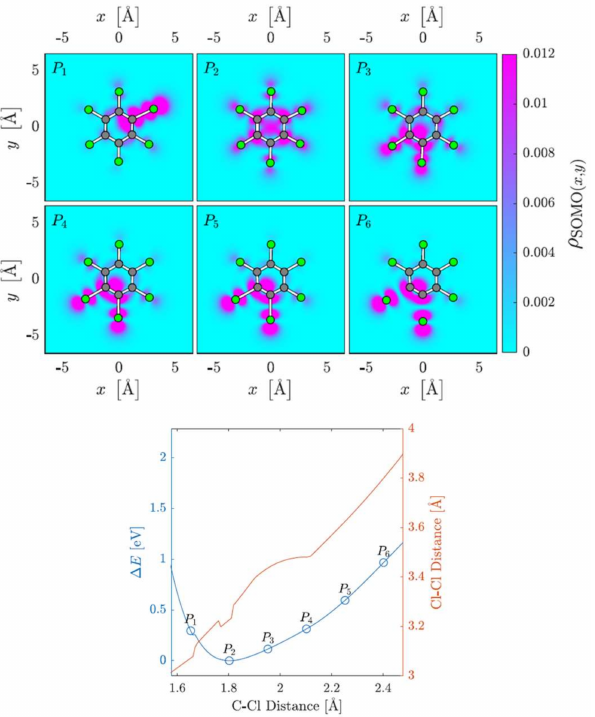
Figure 5. SOMO densities at six different C–Cl internuclear stretching distances and the correspond- ing potential energy